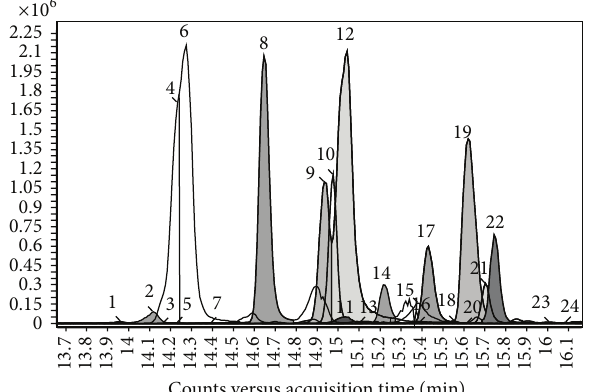
Figure 2: Overlapping of the extracted ion chromatograms (EIC) of [M-H] − ion signals of glycoside flavonols identified in UHPLC/QTOF analysis of hybrid grape Seyve Villard